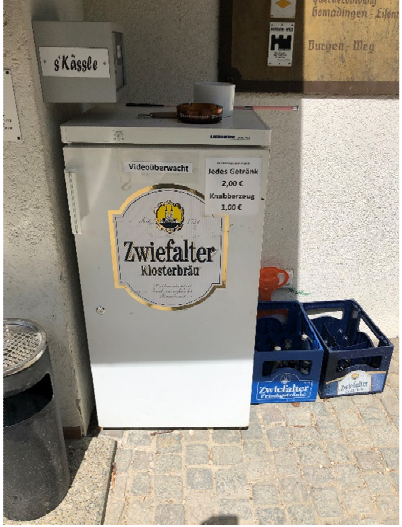
Figure 22. Self-service refrigerator in Gomadingen (Julian Stolz